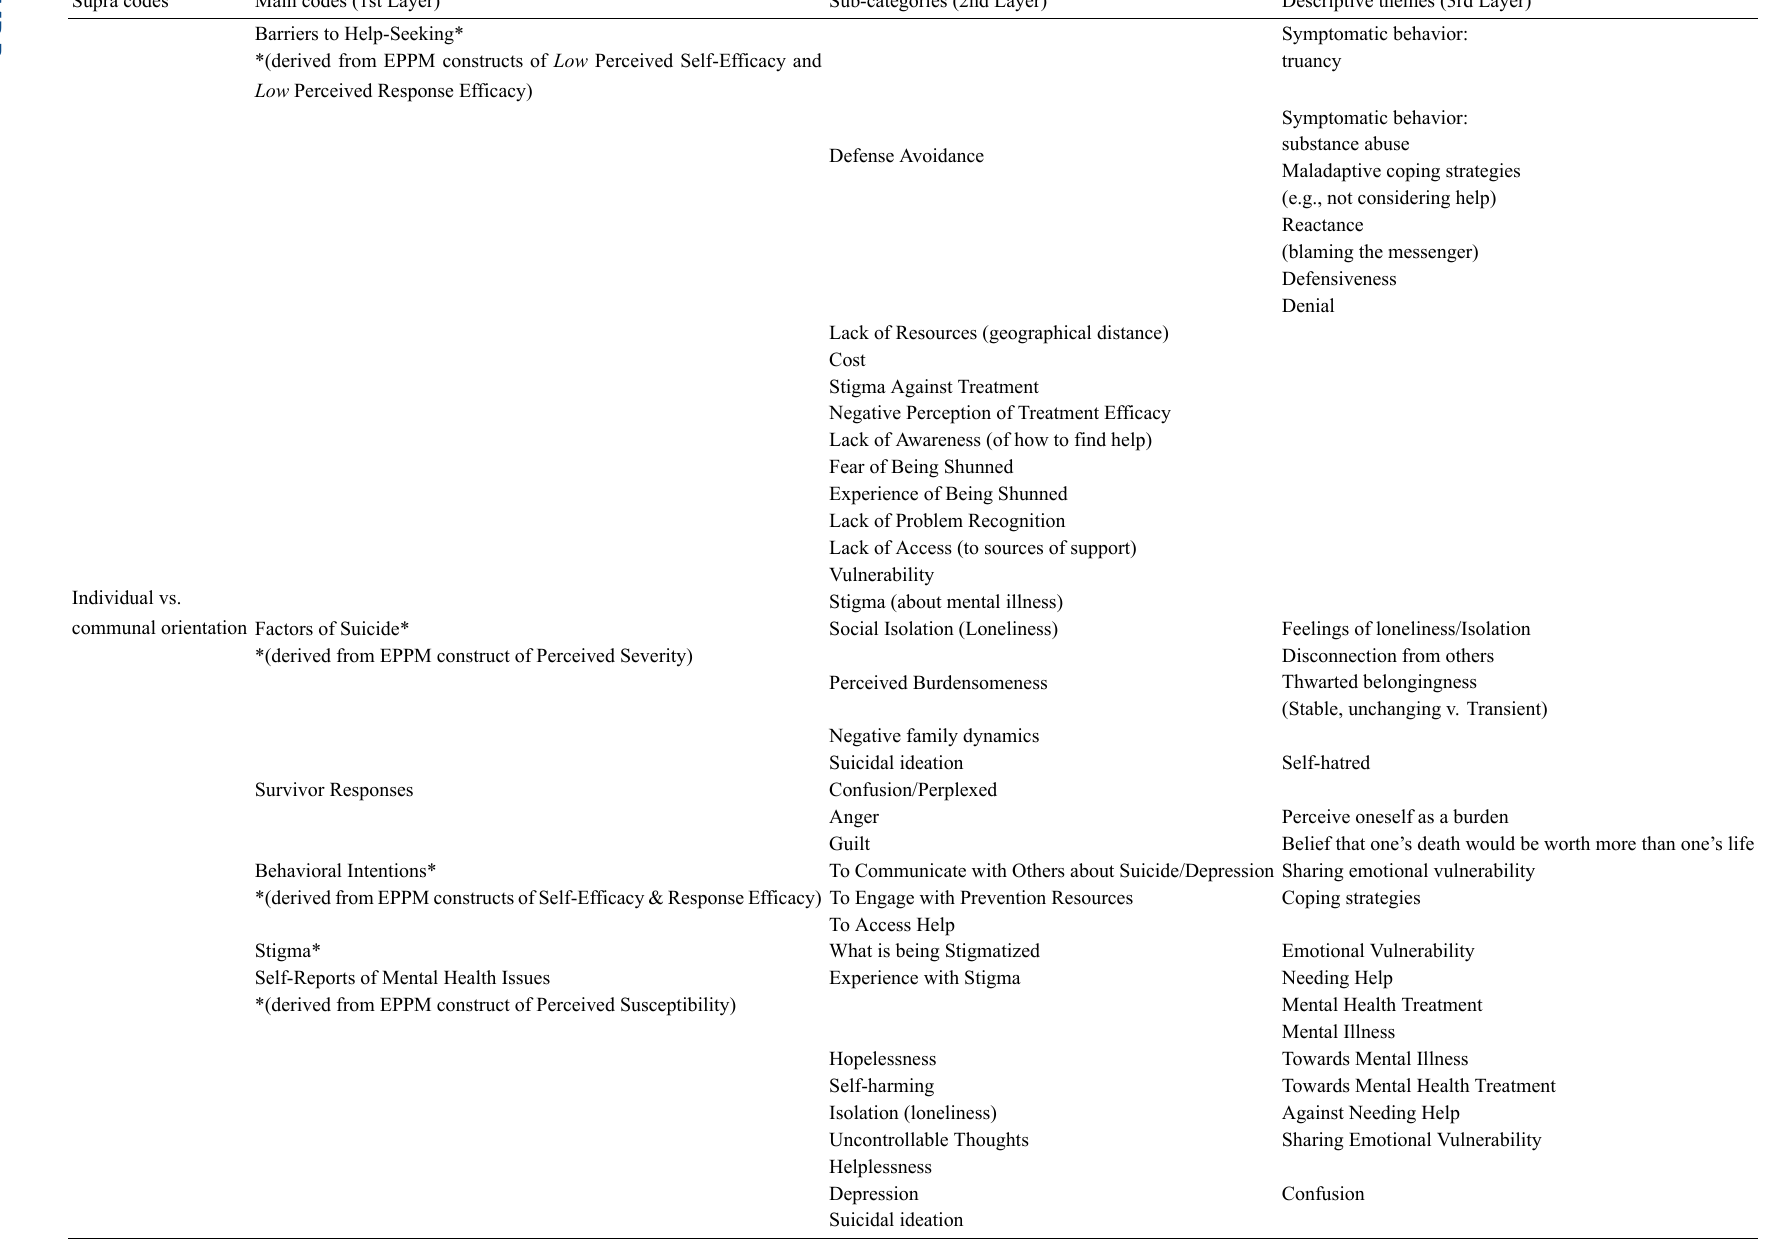
Table 1. Main coding categories, sub-categories and descriptive